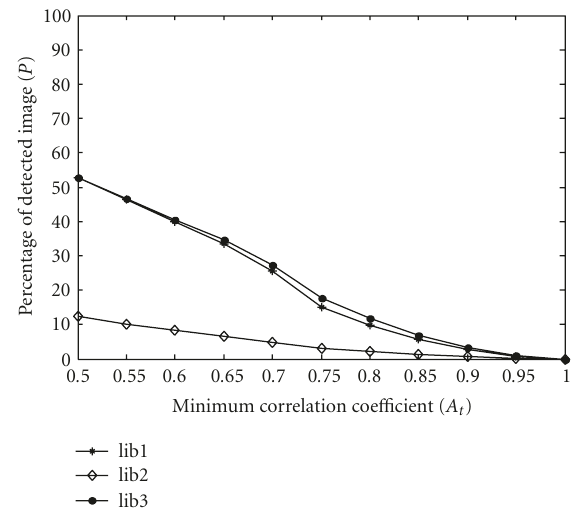
Figure 16: Relationship between the correlation values and the per- centage of detected image ( P ) when two libraries are